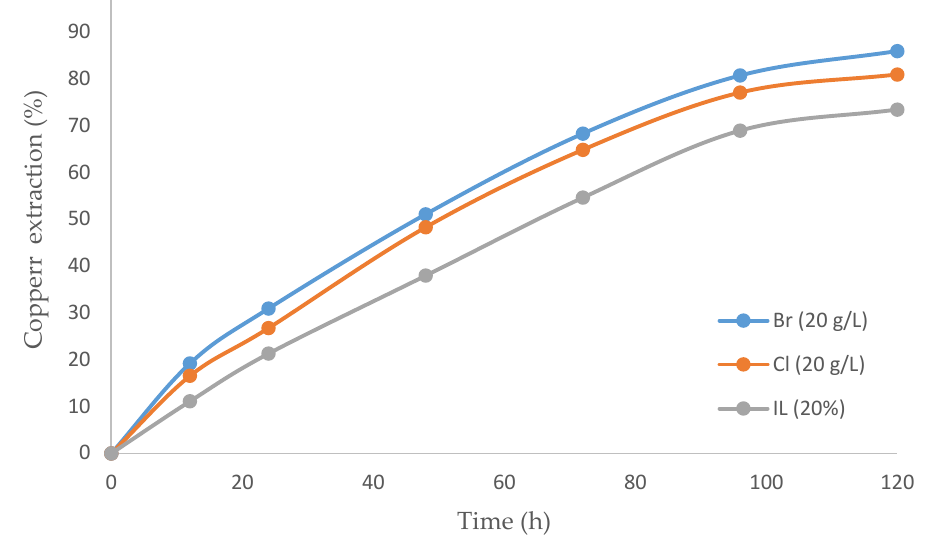
Figure 4. Copper extraction percentage over time (h) comparing: IL with bromine, IL with chloride, and only IL (temperature 80 °C, 20% ( v / v ) [bmim][HSO 4 ], pulp density 10 g/L).